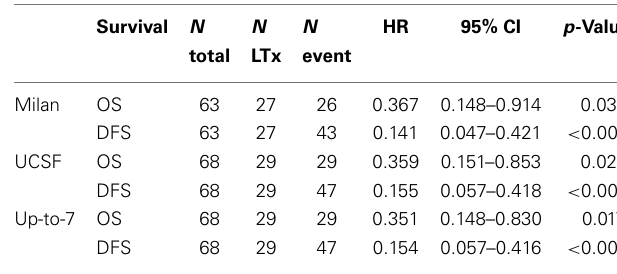
Table 2 | Survival after surgery for HCC as function of liver transplant in patients classified within liver transplant criteria